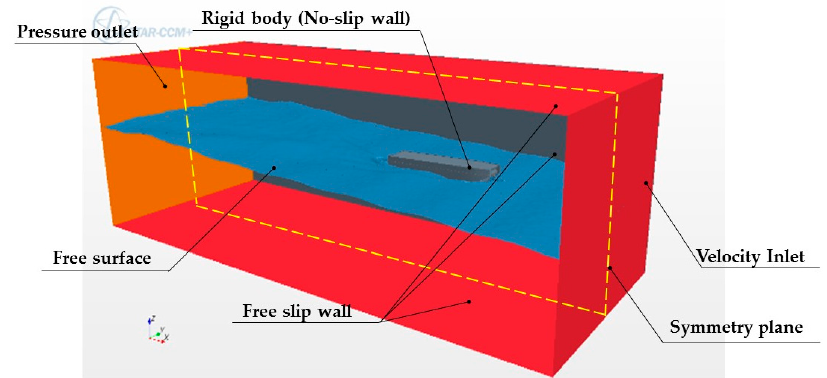
Figure 17. Calculation domain.